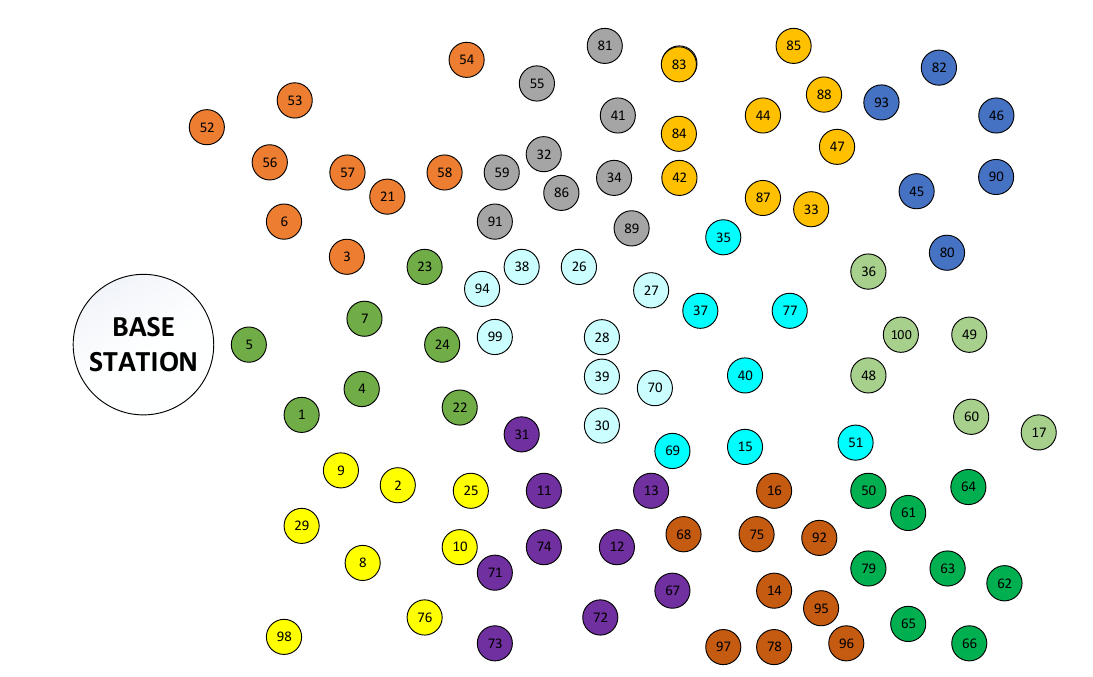
Figure 11. The final state of the network. Table 2. The latest status of the